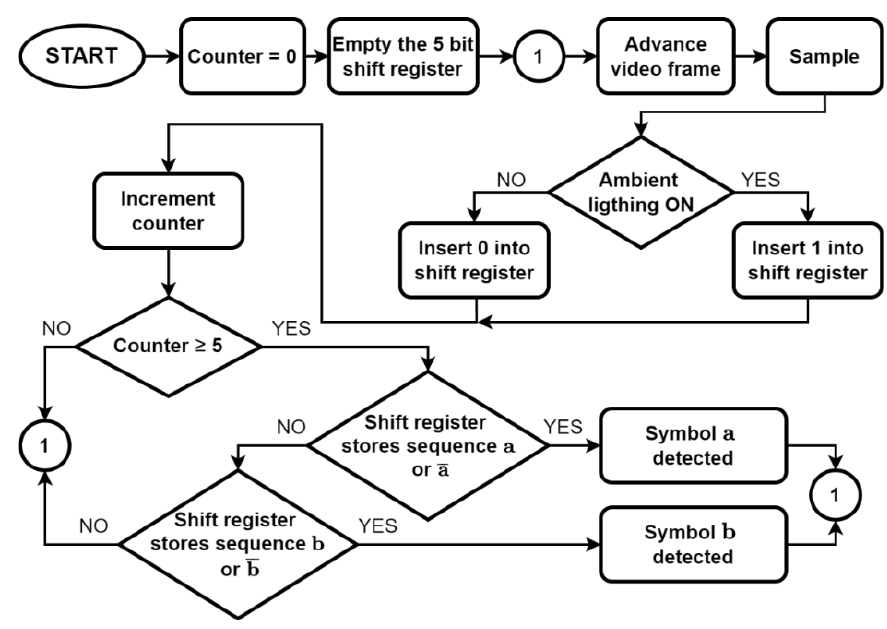
Figure 4. Flow diagram of the detection algorithm.